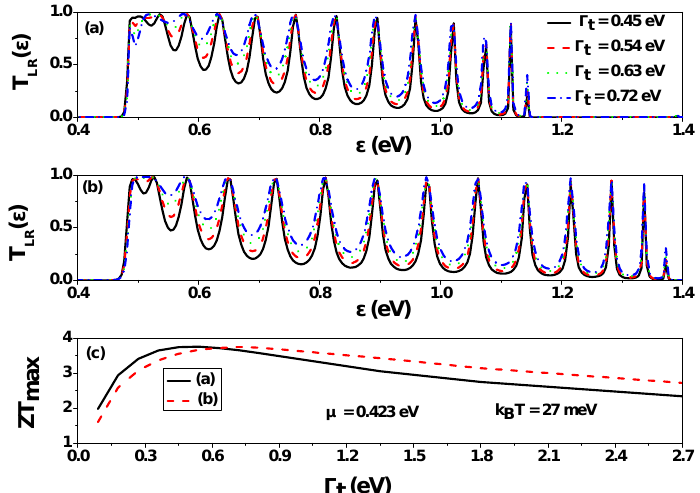
Figure A3. Transmission coefficient in the range of ε > 0 for different tunneling rates. ( a ) Periodically indented structures on both zigzag edge sides and ( b ) periodically indented structures on only one zigzag edge side. ( c ) ZT max of a t-ZGNR consisting of 15 GQDs as a function of the tunneling rate Γ t . Each GQD in the structure has size N a = 8 and N z = 7. The maximum ZT value of SF transmission coefficient at k B T = 27 meV is 3.95167 when its κ ph is adopted to be the same as that of Figure 5.